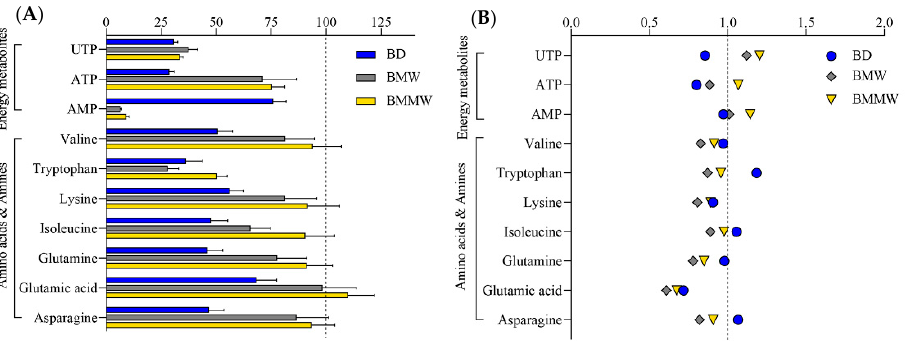
Figure 2. The ( A ) extraction recovery (%) and ( B ) matrix effect of polar ISTDs by using the extraction methods: BD, BMW, and BMMW.